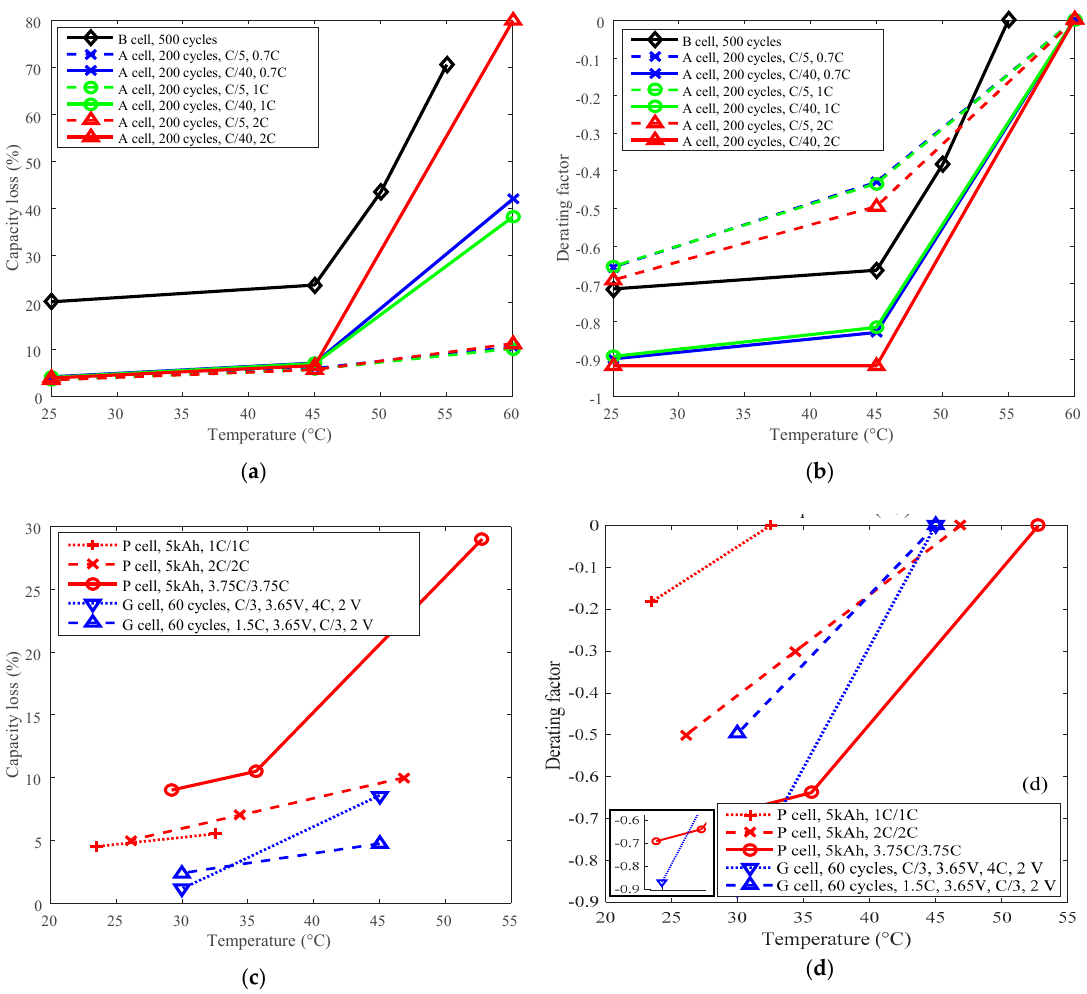
Figure 5. Derating of temperature. ( a ) and ( c ) are for capacity loss vs. temperature, ( b ) and ( d ) are for derating factor vs. temperature.